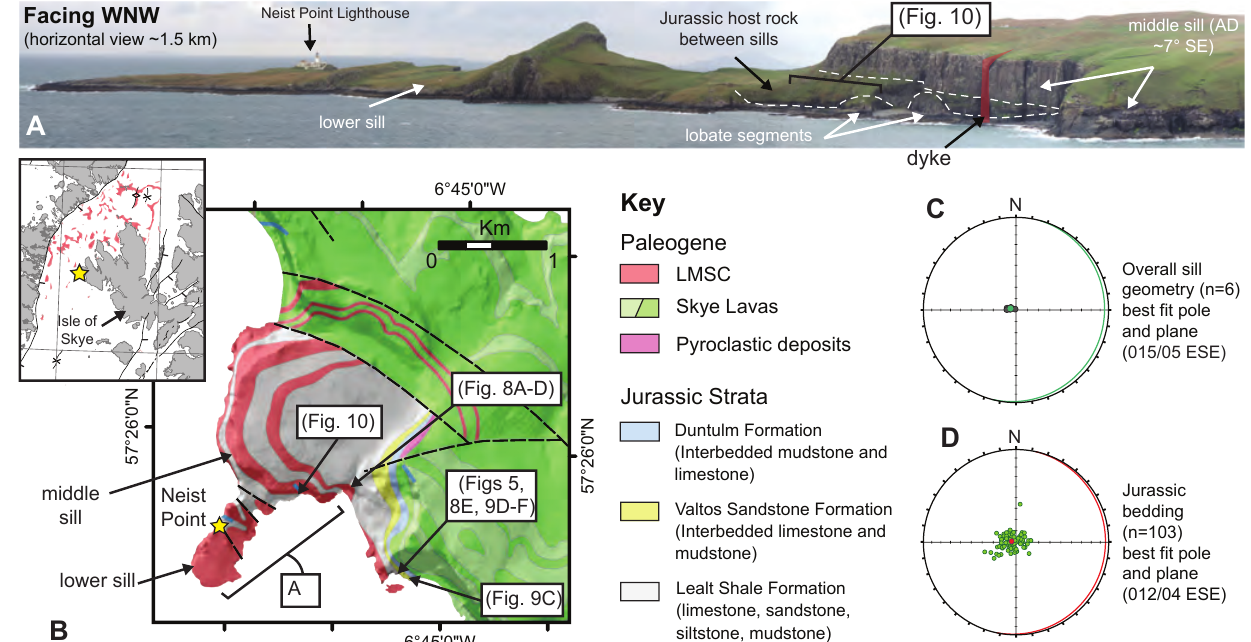
Figure 4: Location of Little Minch Sill Complex study area at Neist Point. [A] Overview photograph of Neist Point showing the lower and middle sills (AD = apparent dip). [B] Location Map for the Neist Point study area and figure locations with bedrock geology shown at 1:50,000 scale [DiGMapGB-50]. The inset map shows the location of Neist Point on the Isle of Skye (yellow star), and the offshore extent of the Little Minch Sill Complex (LMSC) in red (shown at 1:625000 scale [DiGMapGB-625]). [C] Equal-area lower-hemisphere stereonet plotting the three major sills (grey), with average pole and plane (green), given as strike, dip and dip-direction. [D] Equal-area lower- hemisphere stereonet plotting Jurassic bedding as poles to planes (green), with average pole and plane (red) given as strike, dip and